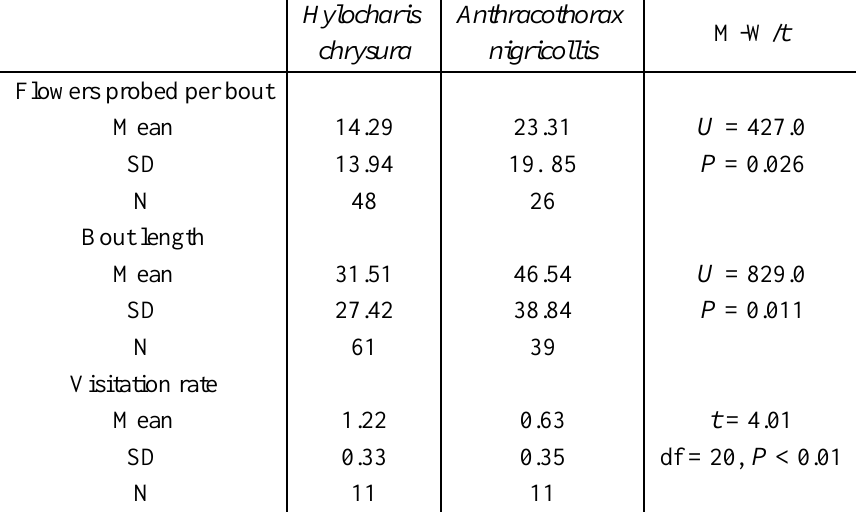
Numbers of flowers probed per foraging bout, bout length (sec.), and visitation rates (bouts per hour) for hummingbird visitors to Palicourea crocea flowers in the Upper Paraná River floodplain. M-W/ t : results of Mann-Whitney ( U ) or t -test ( t